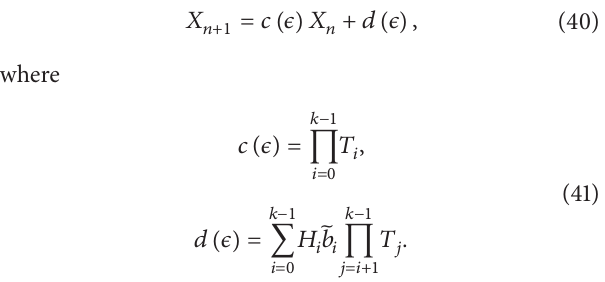
Figure 3: Numerical results of (32) using the explicit Euler method: 𝑘 = 3 (—) and 𝑘 = 10